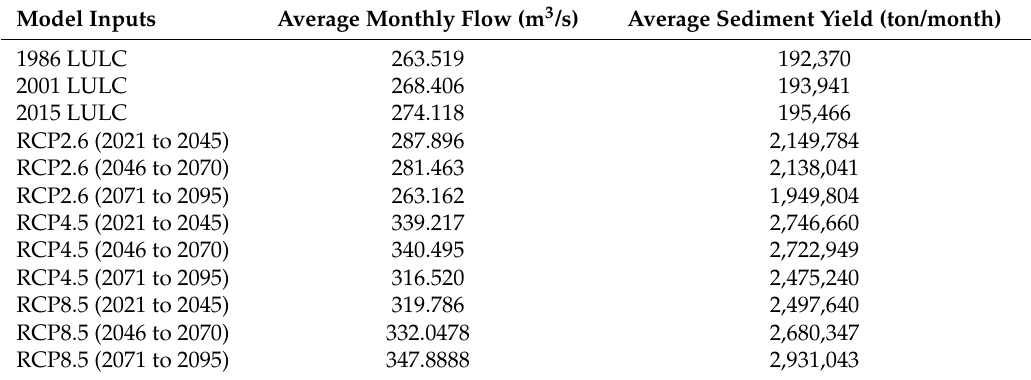
Table 8. Flow and soil loss at the final Didessa river outlet under LULCC and climate change. Model